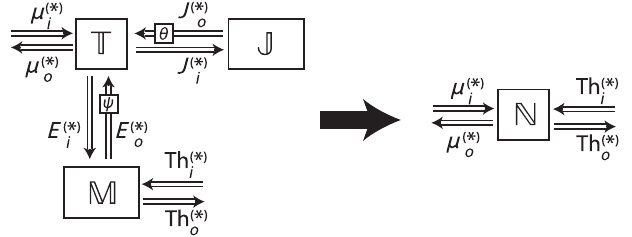
FIG. 5. Control system schematic of the network depicted in Fig. 1(b). The tee, EMC, and JPA components are represented as MIMO linear state-space models that exchange signals contin- uously. The interconnections are labeled here such that, e.g., E ð(cid:7)Þ o stands for the two free-field channels labeled E are explained in the text. Transmission line delays may be modeled here as static phase shifts c and (cid:5) . Standard software toolkits are available that reduce the network on the left to a single MIMO state-space model N . This approach is compatible with both quantum and classical